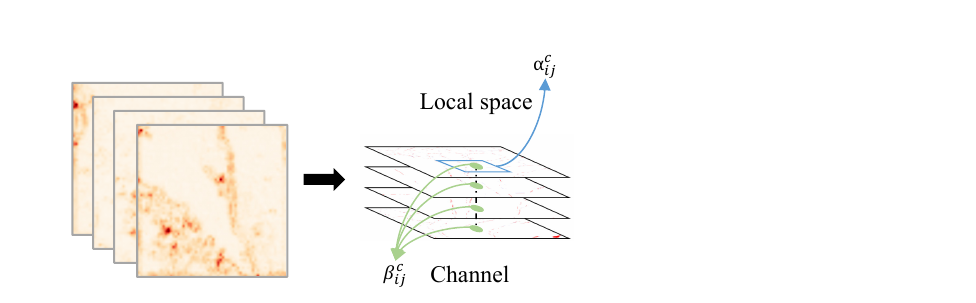
Figure 2. Illustration of peakiness measurement extracted by local- and channel-feature maps.